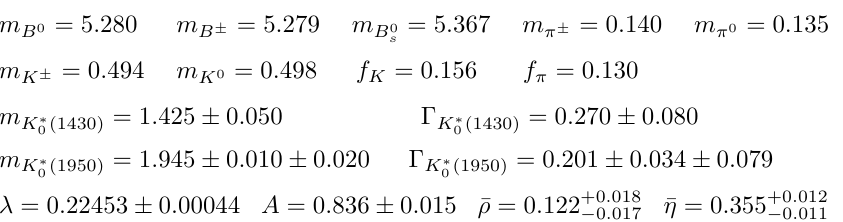
Table 1 . Masses, decay constants, full widths of K (cid:3) Wolfenstein parameters